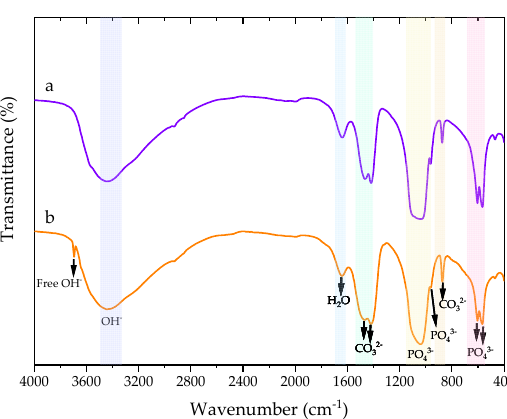
Figure 4. FT − IR absorbance spectra of nHAp powder (a) 1DP − nHAp and (b) 2DP − nHAp. EDS spectra of the nHAp with element composition are shown in Figure 5. Both 1DP − nHAp and 2DP − nHAp have constituents carbon (C), oxygen (O), magnesium (Mg), calcium (Ca), and phosphorous (P). Typically, the presence of Mg constituent is a signifi- cant factor in bone and teeth growth [8]. Hydroxyapatite is a type of calcium phosphate ceramic which is classified by calcium/phosphorus atomic ratio (Ca/P); for example, hy- droxyapatite Ca 10 (PO 4 ) 6 (OH) 2 , HAp, Ca/P = 1.667) and β− tricalcium phosphate ( β− Ca 3 (PO 4 ) 2 , β− TCP, Ca/P = 1.5) [36]. The Ca/P has illustrated the molar ratio from nHAp. The Ca/P of 1DP − nHAp and 2DP − nHAp are 1.63 and 2.01, respectively. The Ca/P of 1DP − nHAp is close to the theoretical value (1.67) [8]. The Ca/P ratio of 2DP − nHAp is higher than the theoretical value due to the substitution of phosphate ions with carbonate ions. These results are the same as the report by Deb and Deoghare [29] and consistent with the FT − IR results.